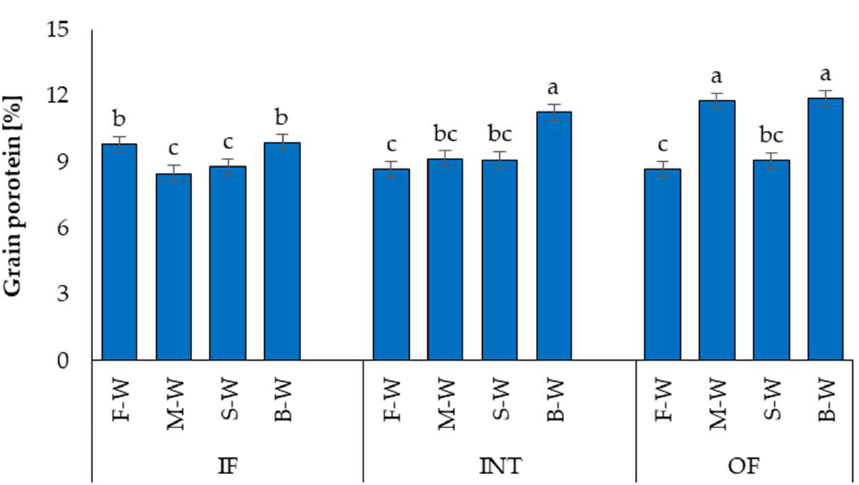
Figure 7. Effect of the interaction between three farm management practices (intensive (IF), organic (OF), and integrated (INT)) and four crop rotation systems (fallow-wheat (F-W), maize-wheat (M-W), sesame-wheat (S-W), and mung bean-wheat (B-W)) on average grain protein content over two years. Different letters above each bar indicate a significant difference at p ≤ 0.05.